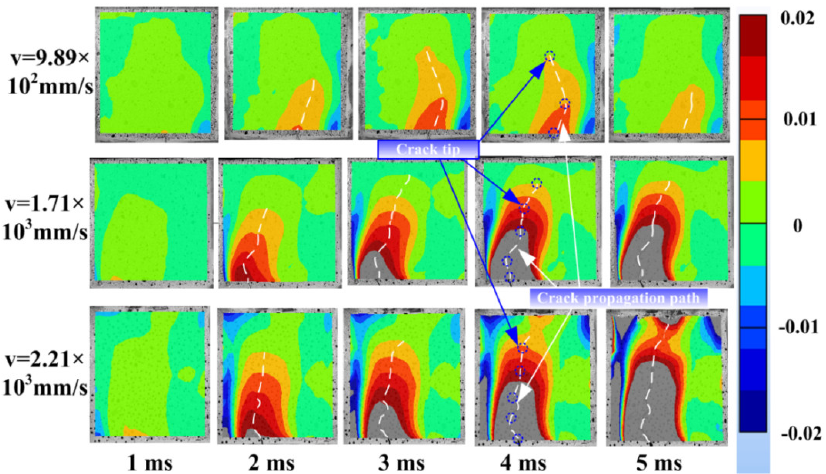
Figure 10. The strain filed in horizontal